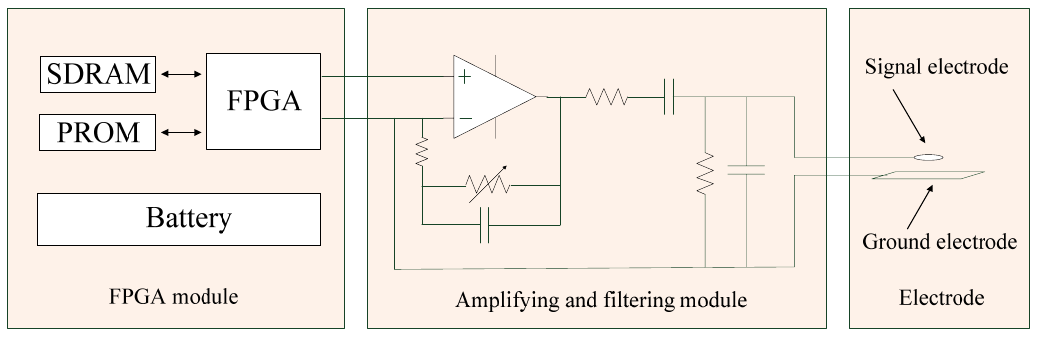
Figure 2. The transmitter